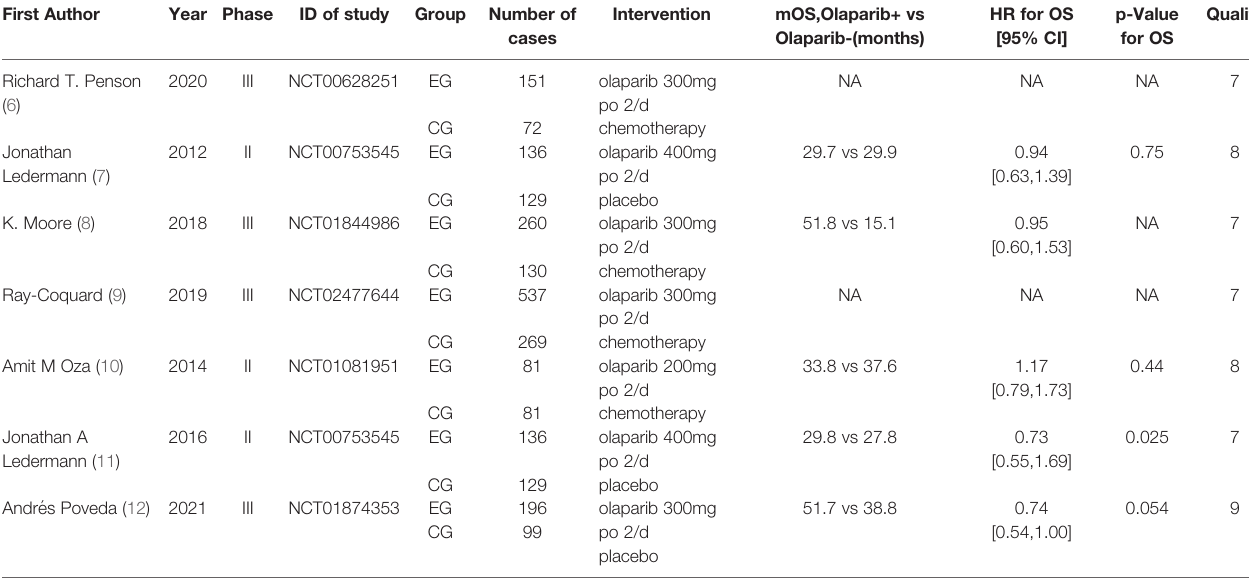
TABLE 1 | Basic characteristics of included studies (6 –